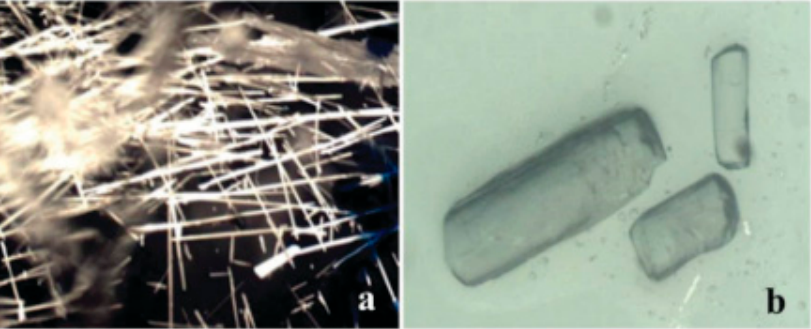
Figure 6. ( a ) Needle shaped crystals of isoniazid grown from DMSO solution and ( b ) block shaped crystals from DMSO ODA/C-CNC gels under the same conditions [116]. Reproduced from [116], The Royal Society of Chemistry,